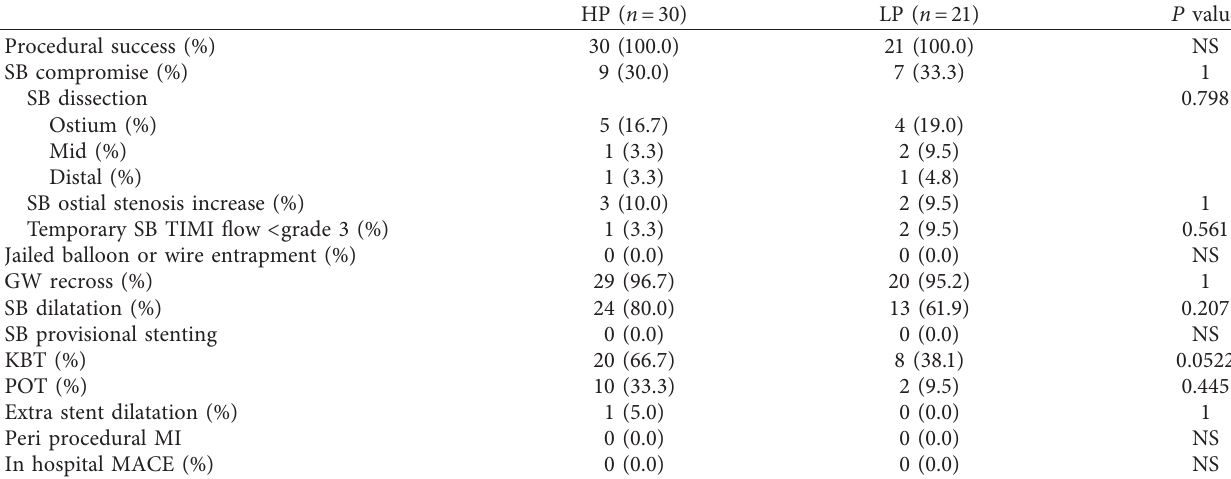
Table 3: Procedural outcomes of modified jailed balloon technique.